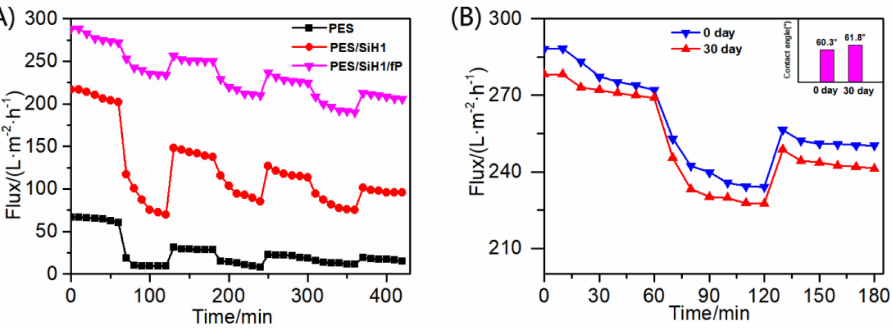
Figure 10. ( A ) The time-dependent fluxes of PES, PES/SiH1, and PES/SiH1/fP membranes during three times of ultrafiltration; ( B ) the time-dependent flux of the PES/SiH1/fP membrane during the oil-in-water emulsion filtration before and after being shaken in water for 30 days.